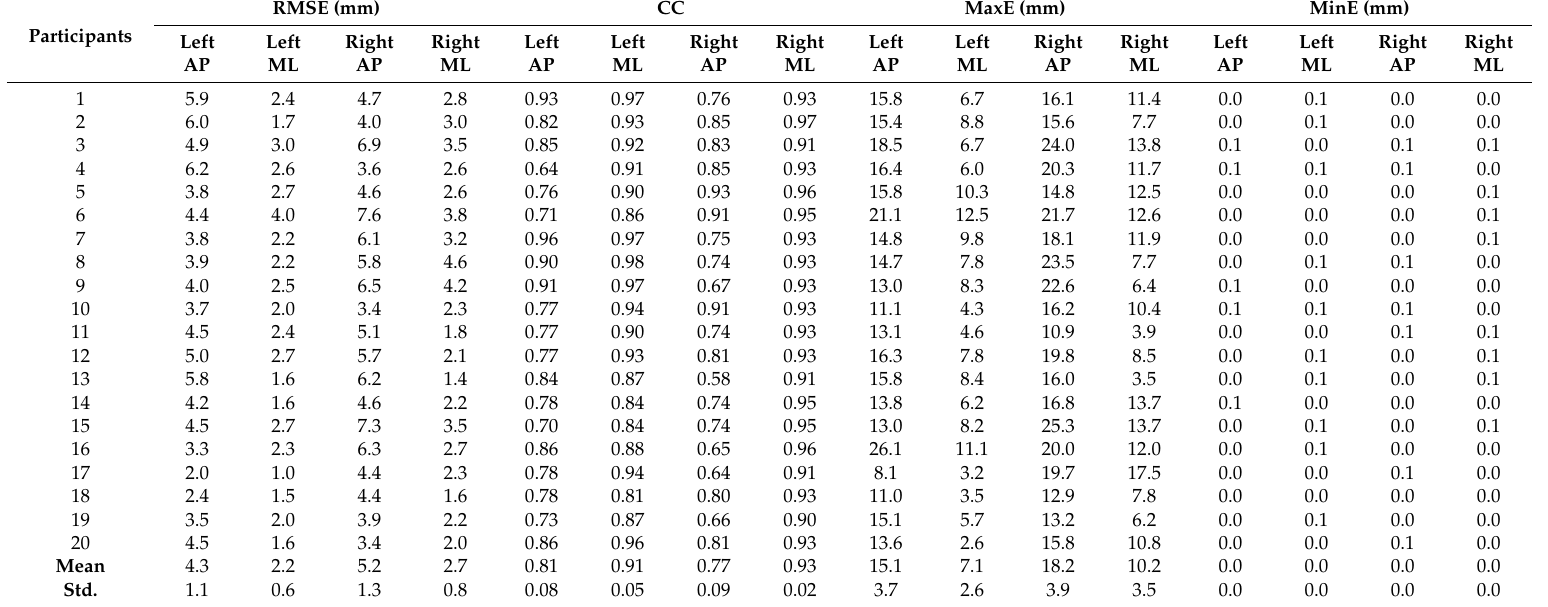
Table 2. The RMSE (Root Mean Square Error), Correlation Coefficient (CC), Maximum Error (MaxE) and the Minimum Error (MinE) of the COP trajectory estimated by the nonlinear mode and the reference measurement, for both feet (L_ and R_), and along the medial-lateral (ML) and anterior-posterior (AP) directions.